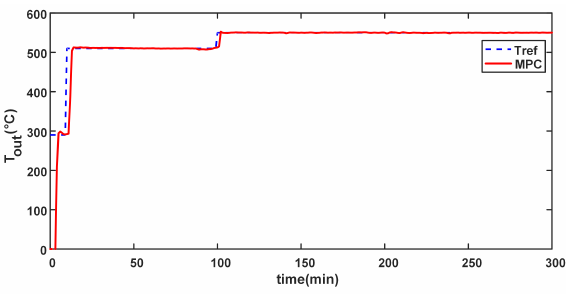
Fig. 5. Collector field outlet temperature under